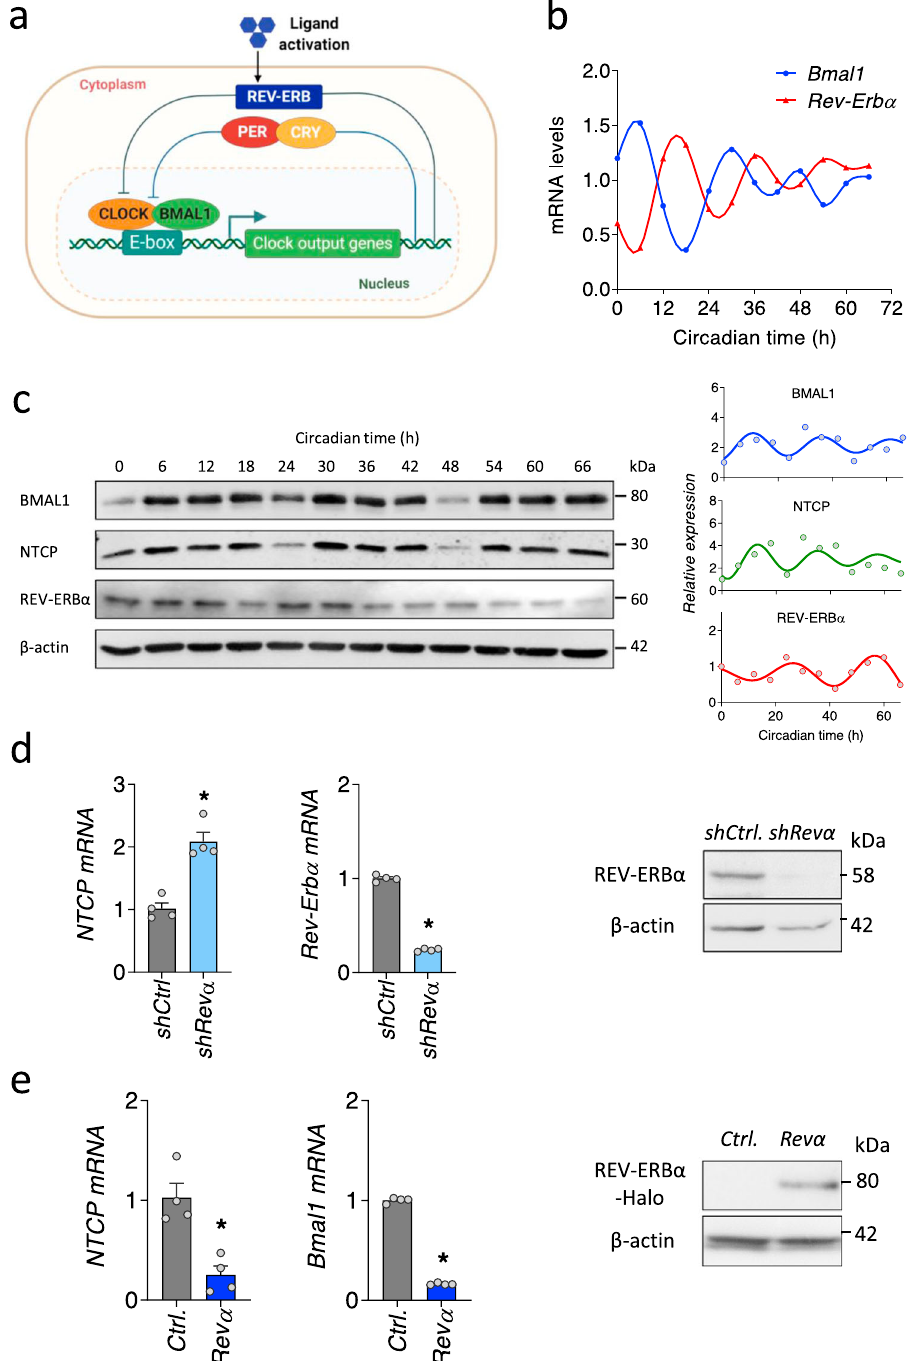
Fig. 1 REV-ERB α coordinates the circadian expression of NTCP. a Circadian transcription – translation feedback loops generate daily rhythmic expression of circadian genes. The molecular clock generates a cycle of 24-hour periodicity when a heterodimeric transcription factor BMAL1-CLOCK activates the transcription from E-box sequences in target gene promoters. Gene products feedback to repress the transcriptional activity of the heterodimeric activator. Ligand activation of REV-ERB represses the transcription of Bmal1. b Synchronization of differentiated HepaRG cells (dHepaRG). dHepaRG cells were treated with dexamethasone at 100nM for 2h and samples collected at 6h intervals. Bmal1 and Rev-Erb α mRNAs were measured by quantitative reverse transcription polymerase chain reaction (qRT-PCR) and expressed relative to the mean. Data are the average of two independent experiments. c Synchronized dHepaRG cells were assessed for BMAL1, NTCP and REV-ERB α expression together with housekeeping β -actin by western blotting. Densitometric analysis quanti fi ed BMAL1, NTCP and REV-ERB α in individual samples and was normalized to their own β -actin loading controls. Data are the average of two independent experiments. d Total RNA was extracted from control or Rev-Erb α silenced HepaRG cells and NTCP and Rev-Erb α mRNA levels measured by qRT-PCR. REV-ERB α expression together with housekeeping gene β -actin were assessed by western blotting. Data are expressed relative to control (mean±SEM, n = 4, Mann – Whitney test, Two-sided). e Total RNA was extracted from control or Halo-tagged Rev-Erb α overexpressed HepaRG cells and Bmal1 and NTCP mRNA levels measured by qRT-PCR. Data are expressed relative to control (mean±SEM, n = 4, Mann – Whitney test, Two-sided). * p <0.05. Data are provided in the accompanying Source Data fi le.